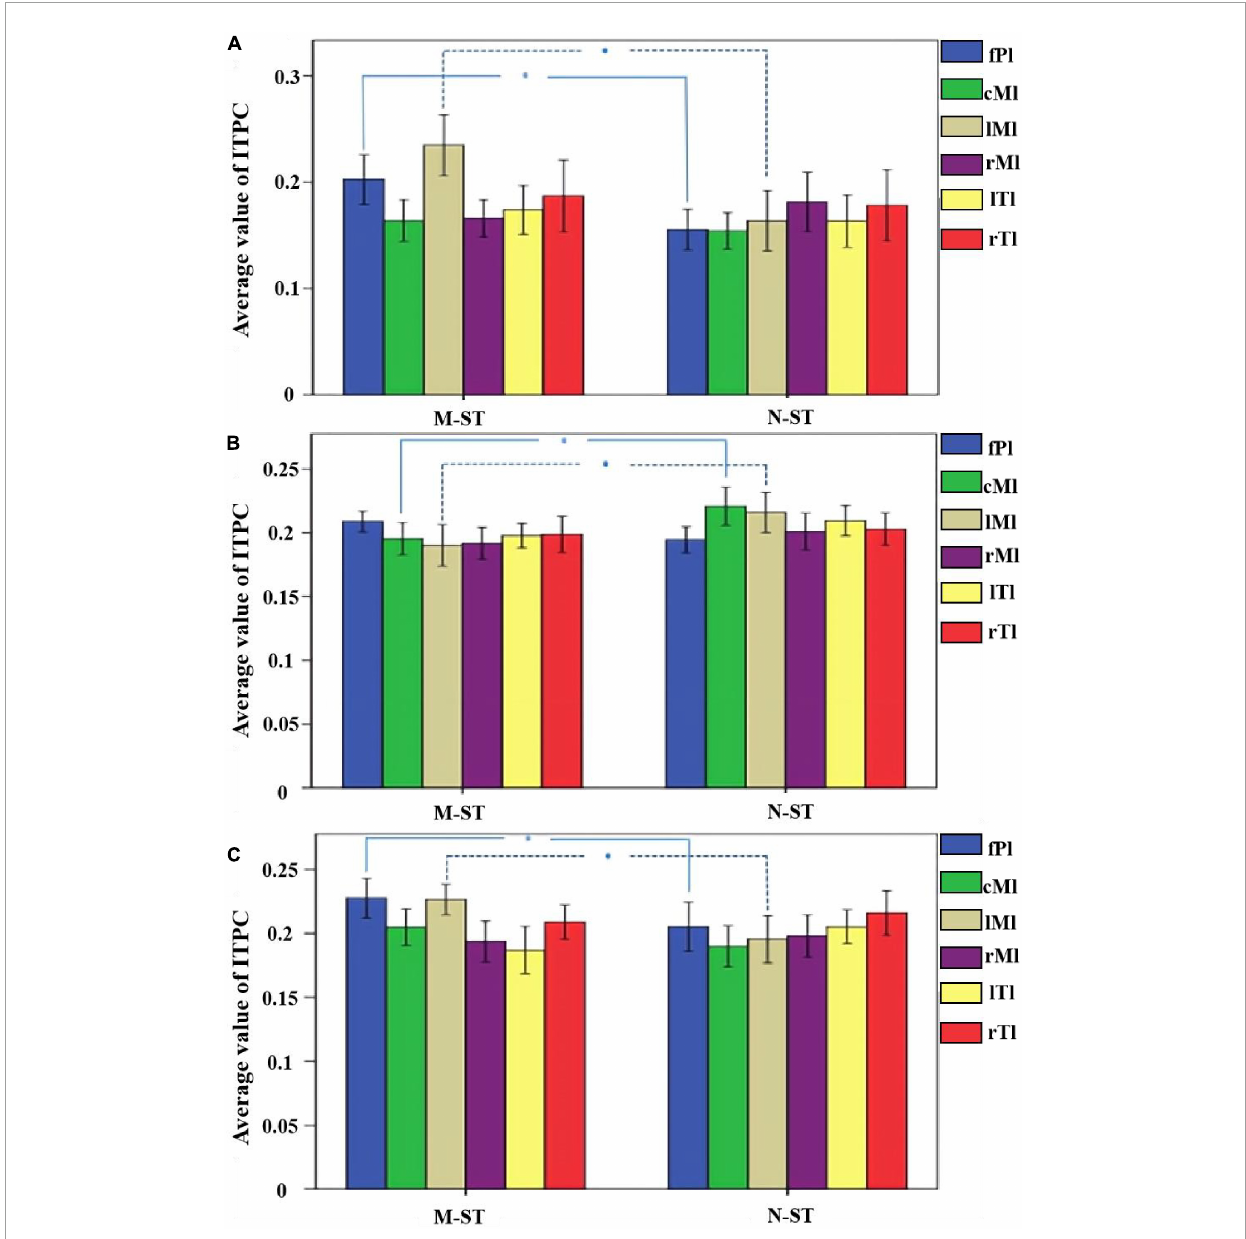
FIGURE9 The mean ITPC values of 18 subjects in different brain regions and different frequency bands. (A) The mean value of ITPC within the alpha band. (B) The mean value of ITPC within the beta band. (C) The mean value of ITPC within the gamma band. ∗ Refers to p < 0.05 with one-way ANOVA. The results of statistical analysis showed that the ITPC values of prefrontal cognitive cortex and left parietal motor cortex in M-ST group were significantly higher than those in N-ST group in alpha frequency band, the ITPC values of parietal motor cortex and left parietal motor cortex of N-ST group were significantly higher than those of M-ST group under bate frequency band, and ITPC values of prefrontal cognitive cortex and left parietal motor cortex of M-ST group under gamma band were significantly higher than those of N-ST